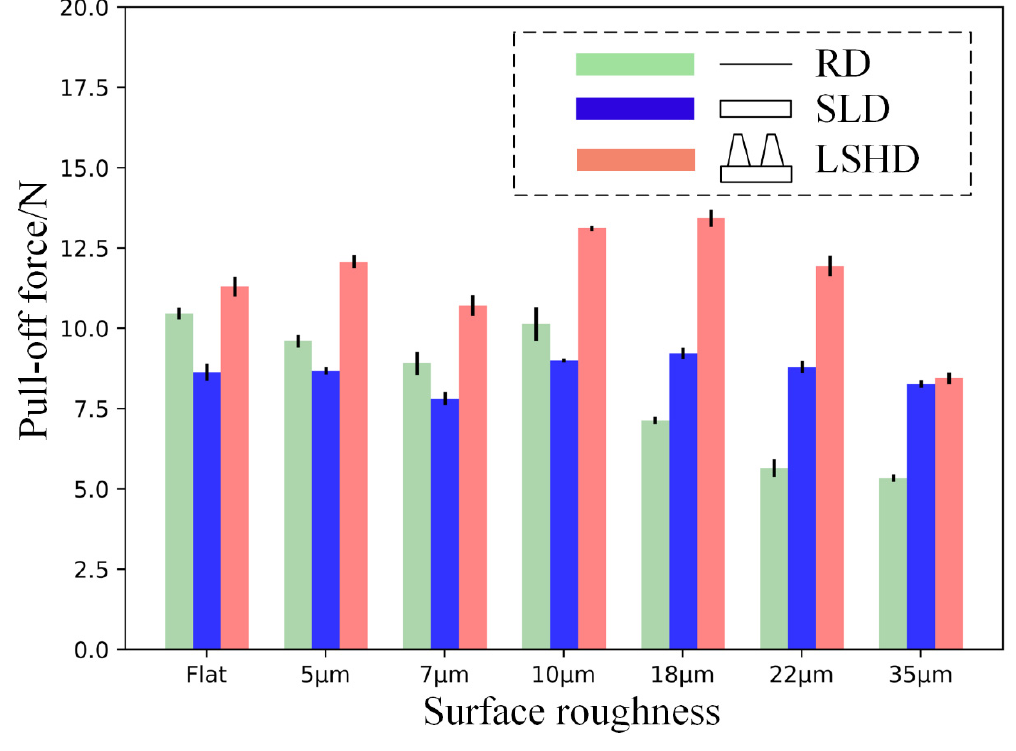
Figure 7. Influence of surface roughness on the pull-off force.